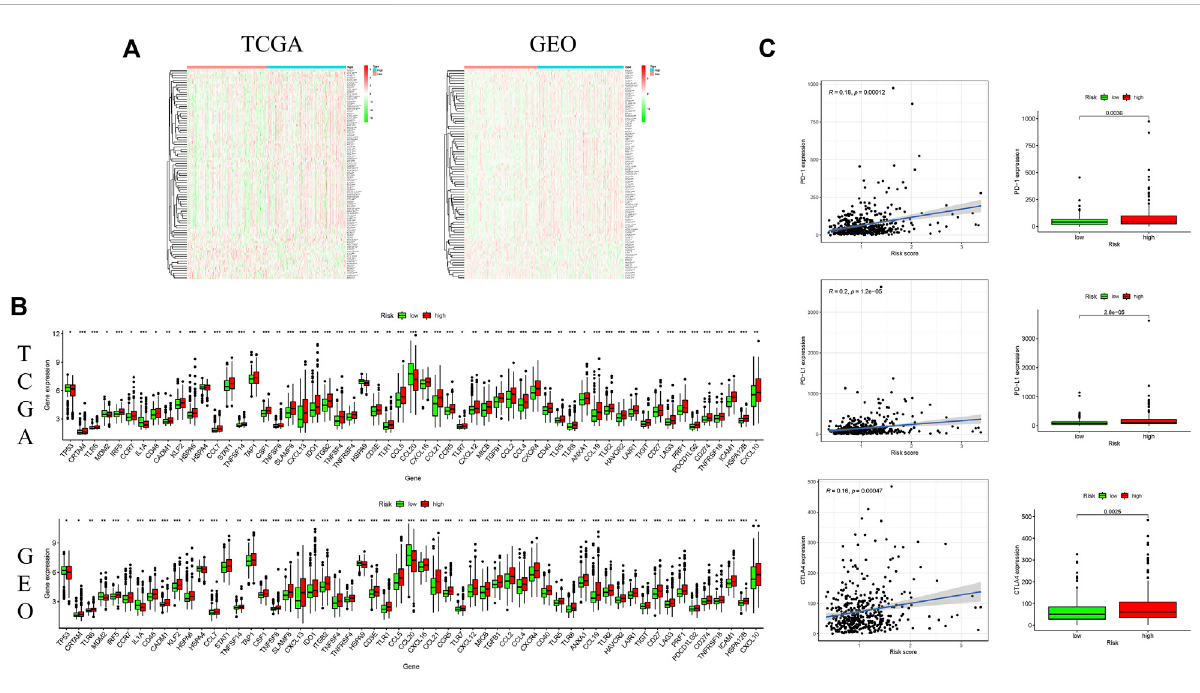
FIGURE 7 Correlation of ferroptosis-associated gene signature with immunity microenvironment. (A) Heatmaps of gene pro fi les of the cancer-immunity cycleintworiskgroupsintheTCGAandGEOcohorts; (B) comparisonofthecommondifferentialimmunegeneexpressionbetweentworiskgroups in the TCGA and GEO cohorts; (C) comparison of immune checkpoint expression between two risk groups. * p < 0.05, ** p < 0.01, and *** p < 0.001.